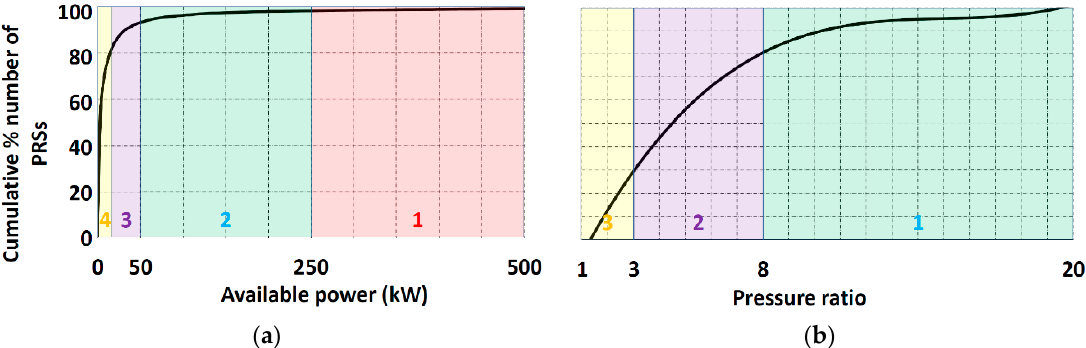
Figure 2. Cumulative percentage distribution of the number of pressure reduction stations (PRSs) (included in the available sample) against ( a ) annual-averaged available mechanical power and ( b ) pressure ratio of the processed natural gas.